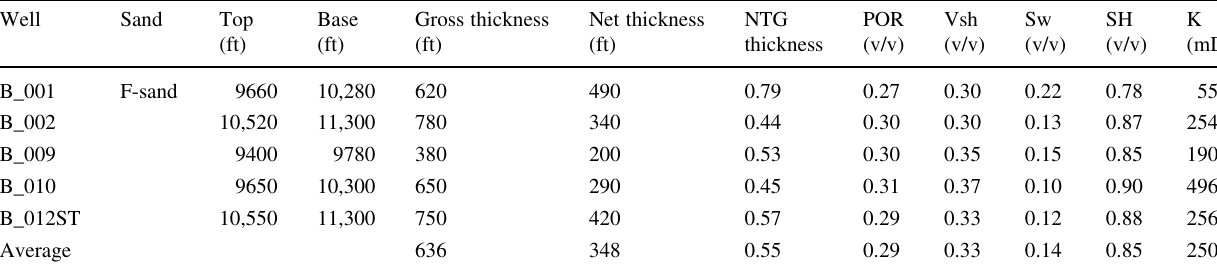
Table 1 Petrophysical evaluation of the F-sand in the wells of the field